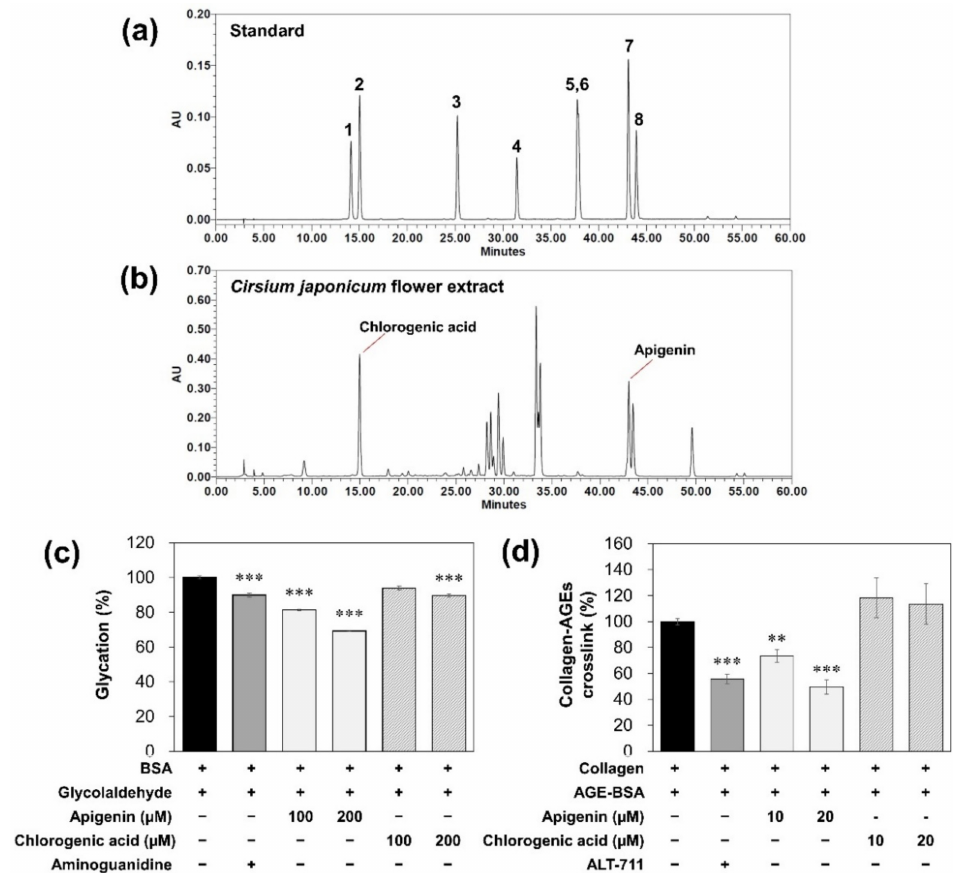
Figure 4. Effects of apigenin and chlorogenic acid in CFE on glycation. ( a ) Analysis of standards composed of flavonoids and phenolic compounds. (1) Scopolin; (2) chlorogenic acid; (3) scopo- letin; (4) myricetin; (5) quercetin; (6) luteolin; (7) apigenin; (8) kaempferol. ( b ) Analysis of CFE. ( c ) Fluorescence intensity of AGEs in GA-modified BSA for 5 days of incubation. These data were represented calculated as a percentage (%) of the fluorescence intensity of the sample compared to the control (BSA+/GA+). ( d ) The breaking activity on cross-links of collagen–AGEs. These data were represented calculated as a percentage (%) of the absorbance of the sample compared to the control (collagen+/AGE+). Statistical significances were represented as follows: **, p < 0.01; ***, p < 0.001 compared to control